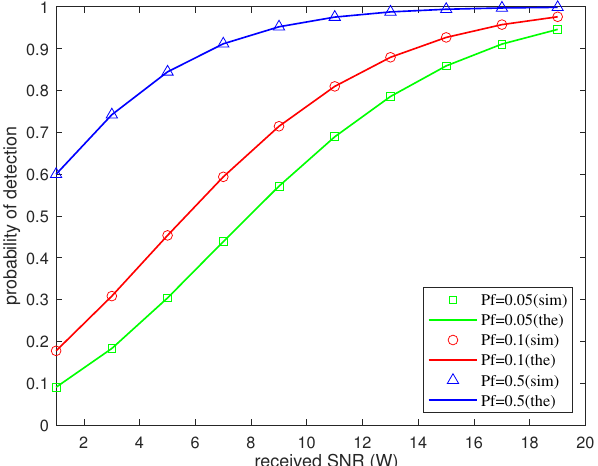
Figure 9. Probability of detection ( P d ) versus the received SNR ( γ i